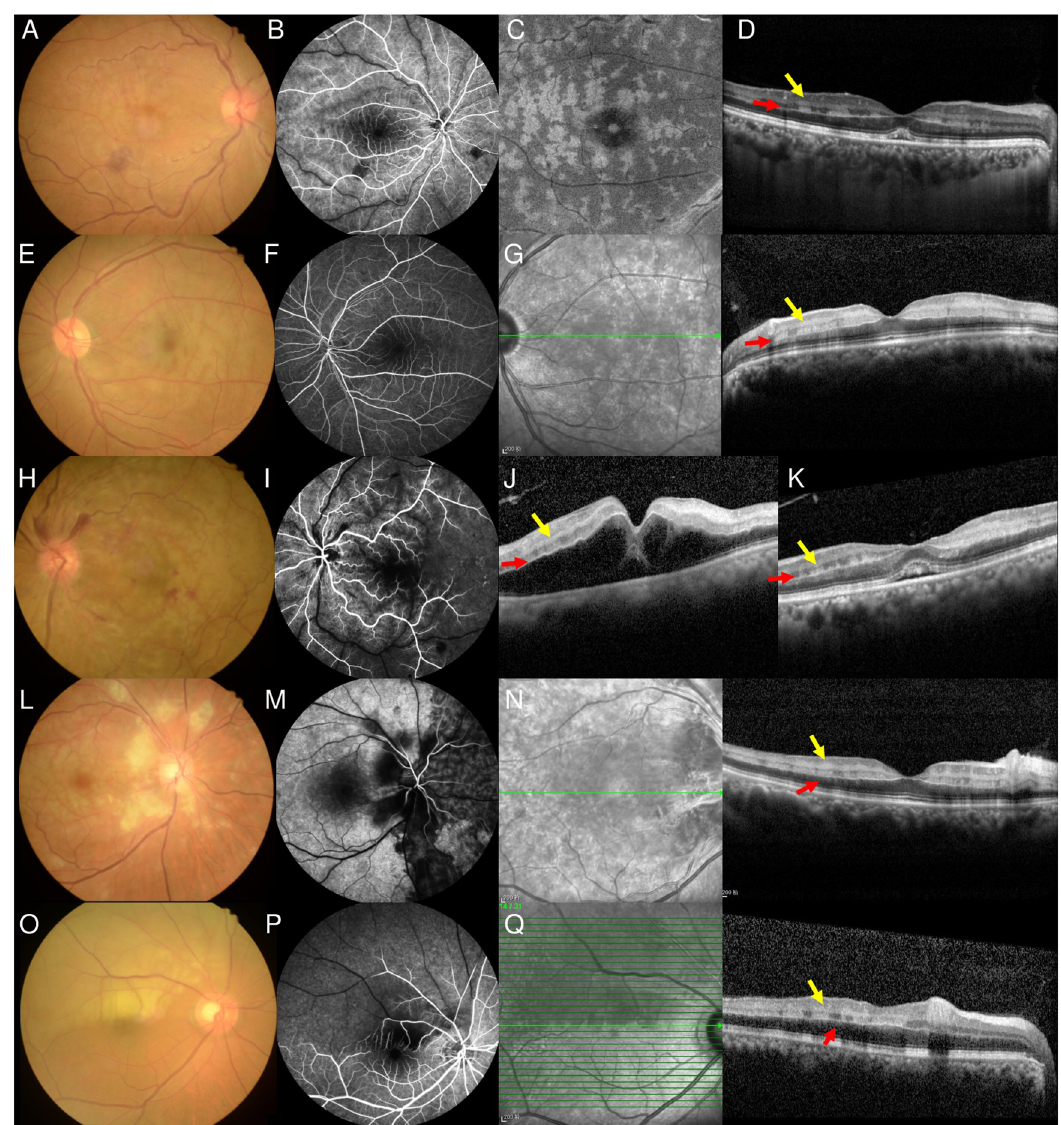
Fig 3. Multimodal imaging findings from the patient with retinal ischemic diseases. Line 1: A 47-year-old woman diagnosed with CRVO (A, B); en-face OCT reveals perivenular fern-like PAMM lesions (C); OCT reveals skip PAMM lesions (yellow arrow) and continuous hyperreflective line of the p-MLM sign (red arrow) (D). Line 2: A 55-year-old man diagnosed with CRAO (E, F); OCT reveals skip PAMM lesions (yellow arrow) and continuous hyperreflective line of the p-MLM sign (red arrow) (G). Line 3: A 69-year-old woman diagnosed with CRAO combined with CRVO (H, I); OCT before (J) and after (K) anti-vascular endothelial growth factor treatment all shows skip PAMM lesions (yellow arrow) and continuous hyperreflective line of the p-MLM sign (red arrow). Line 4: A 42-year-old man diagnosed with CRAO. Fundus photos reveal cotton wool spots around the optic disc (L); fluorescent angiography reveals delayed retinal artery perfusion and nasal choroidal perfusion (M). OCT reveals skip PAMM lesions (yellow arrow) and continuous hyperreflective line of the p-MLM sign (red arrow) (N). Line 5: A 63-year-old man diagnosed with BRAO (O, P). OCT reveals skip PAMM lesions (yellow arrow) and continuous hyperreflective line of the p-MLM sign (red arrow) (Q). OCT: optical coherence tomography, PAMM: paracentral acute middle maculopathy, p-MLM: prominent middle limiting membrane, CRVO: central retinal vein occlusion, CRAO: central retinal artery occlusion, BRAO: branch retinal artery occlusion.